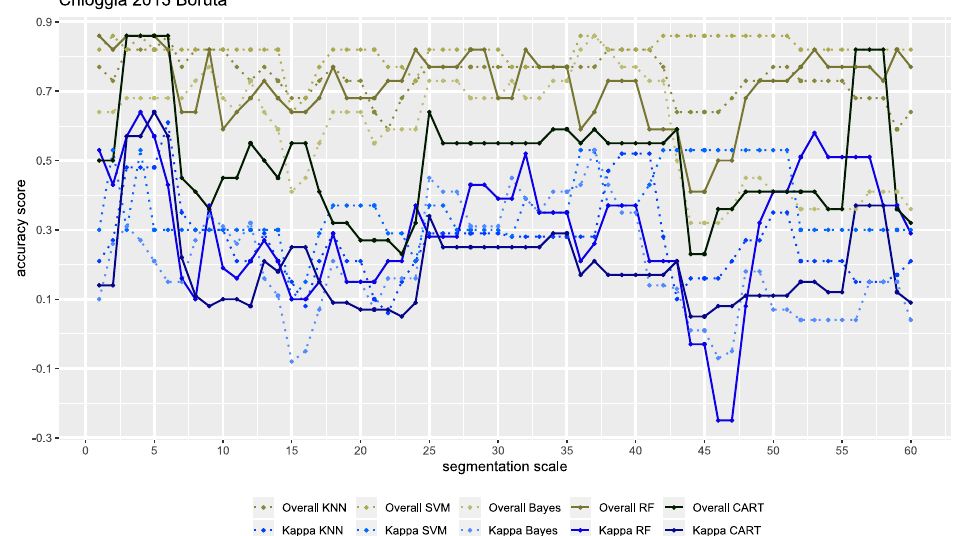
Figure A1. Overall and kappa accuracy assessment charts for scales of multiresolution segmentation 1–60. Chioggia 2013 dataset divided for four classes, Boruta feature-selection algorithm.